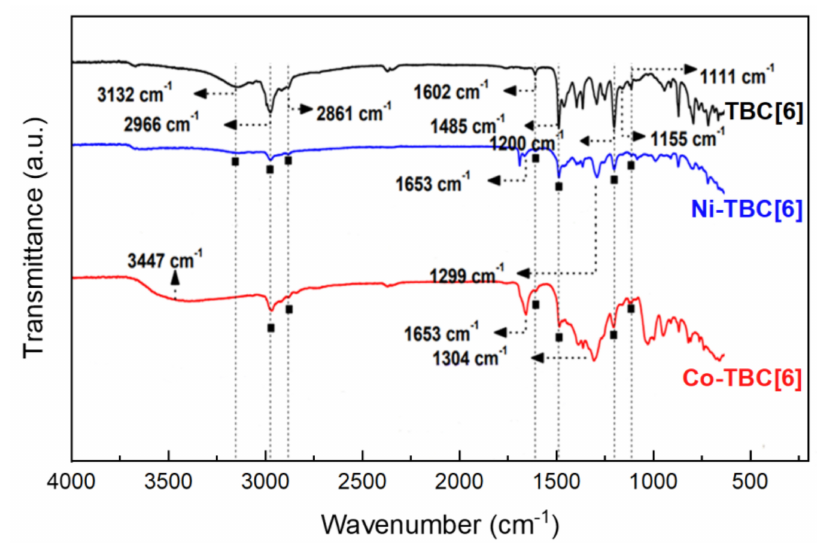
Figure 2. FT-IR spectra of TBC[6], Ni-TBC[6], and